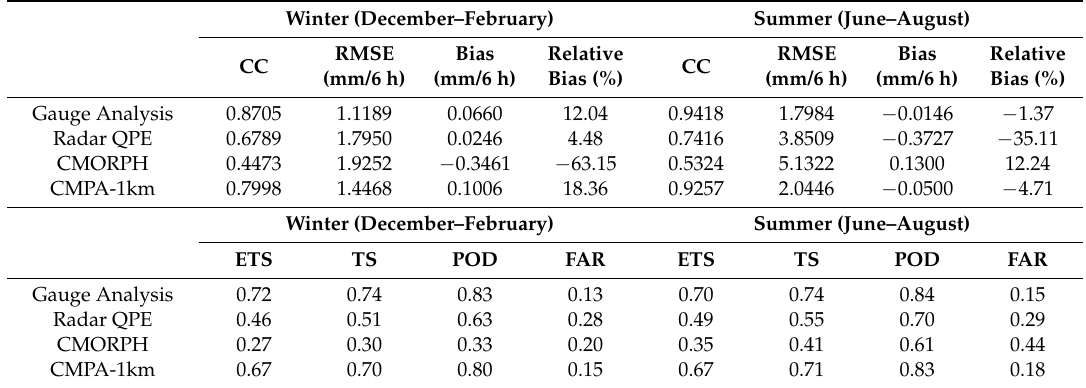
Table 6. Evaluation metrics of individual precipitation observations in summer and winter seasons at a 6-h temporal resolution. The threshold value is 1.0 mm. ETS, equitable threat score; POD, probability of